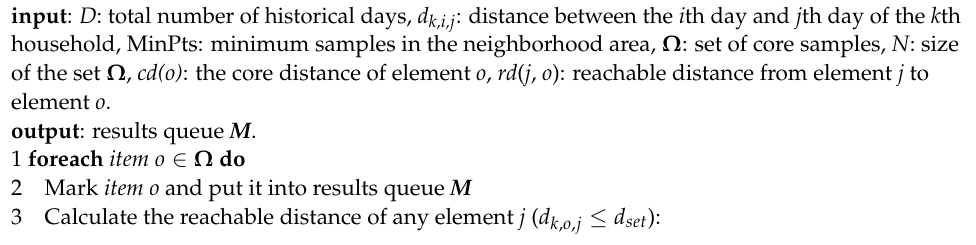
Algorithm 1 The Clustering Subprocedure 1